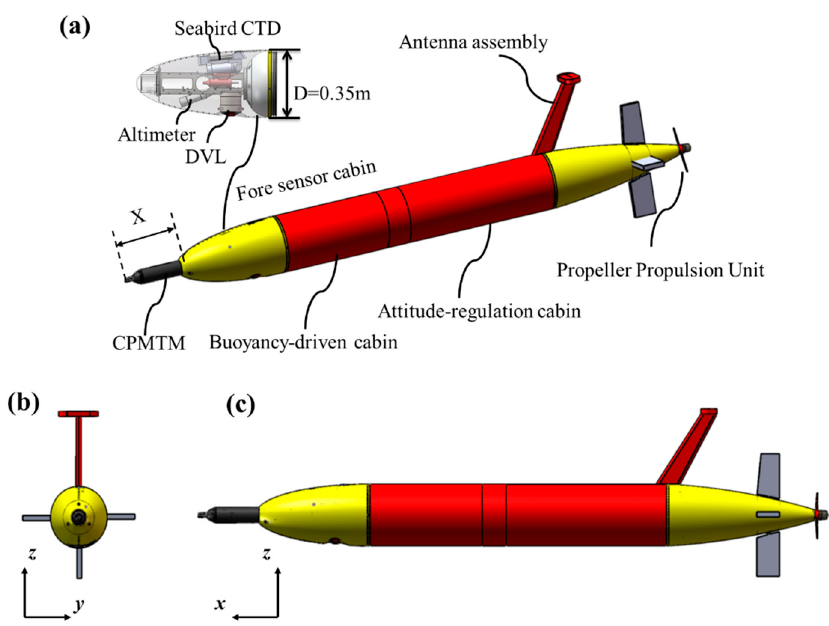
Figure 1. The turbulence AUV configuration. ( a ) Detailed structural components and oceanographic sensors of turbulent AUV. The CPMTM is housed in the center of the fore sensor cabin with the shear probes ahead of the nose by X distance. ( b ) Front view. ( c ) Side view.